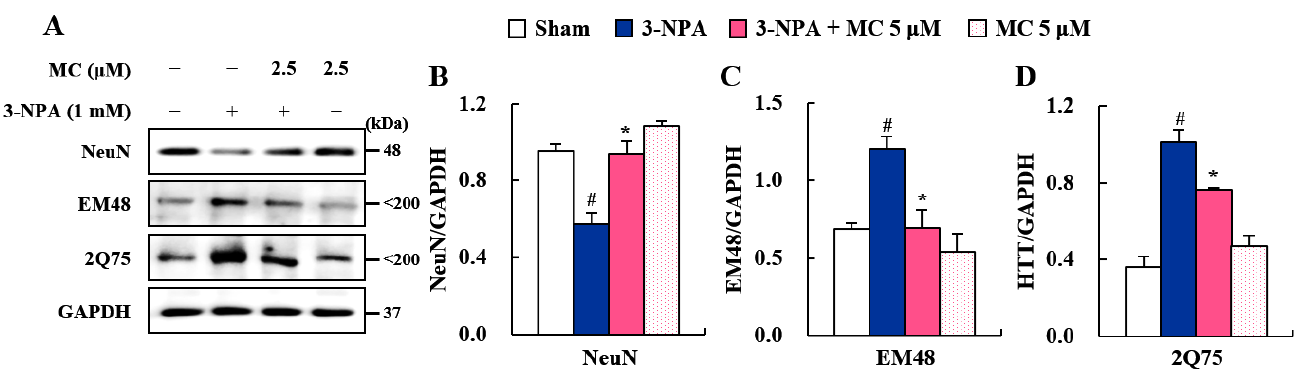
Figure 6. MC enhances the activity of ST Hdh cells by inhibiting the expression of p-STAT3 in BV2 cells. ( A – D ) To obtain conditioned medium (CM) treated with MC, cultured BV2 cells were treated with MC (5 μM) before stimulation with 3 -nitropropionic acid (3-NPA) (1.0 mM, 12 h). CM-3-NPA and CM-3-NPA-MC were used to treat ST H dhQ111/Q111 (mutant) cells. ST H dh cells were used for Western blot analysis to evaluate neurodegeneration using NeuN antibody ( A , B ) and huntingtin aggregation using EM48 and 2Q75 antibodies ( A , C , D ). Data are expressed as mean ± SEM (Kruskal – Wallis; # p < 0.05 vs. vehicle-treated Sham group; * p < 0.05 vs. 3-NPA-induced group).